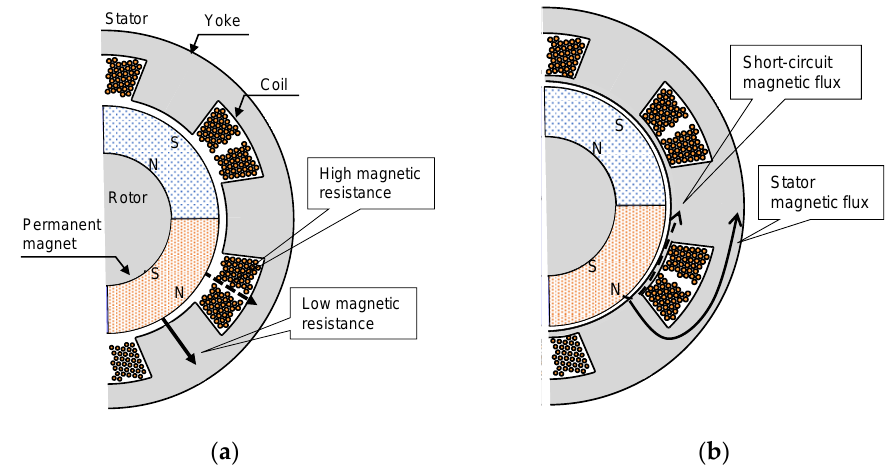
Figure 1. Difference of magnetic flux with open- and closed-slot motor: ( a ) open-slot motor and ( b ) closed-slot motor with an electrical steel sheet. Spatial harmonics are likely to occur in open-slot motors with a large difference in magnetic resistance.